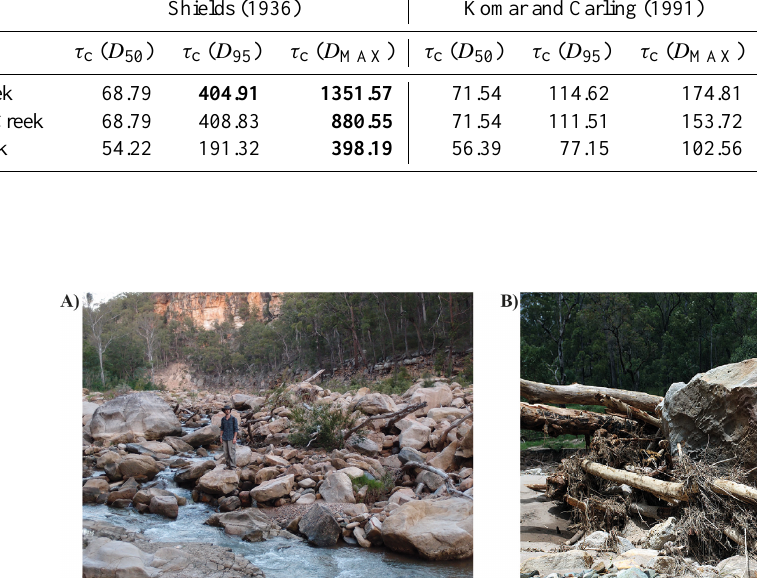
Table 3. Results of flow competence equations for the 2011 flood; bold values indicate that sediment entrainment is not predicted. τ c : critical shear stress (Nm − 2 ); q ci : critical unit discharge for the movement of particles of size D . Shields (1936) Komar and Carling (1991)